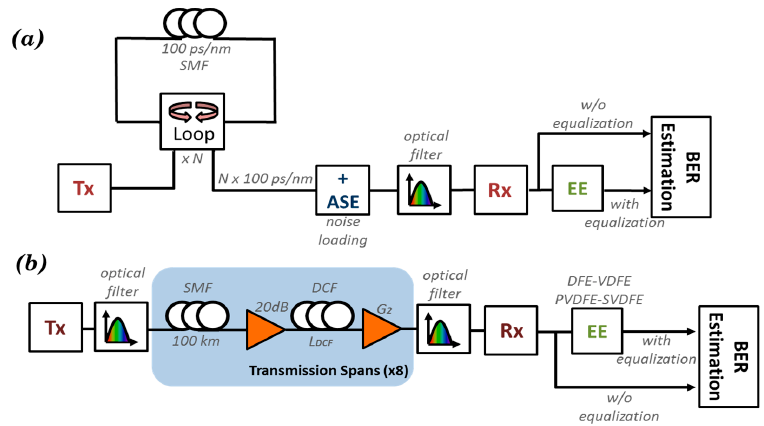
Figure 7. Simulation generic setup for ( a ) a noise-loading technique and ( b ) multi-span scenarios with eight spans. eight